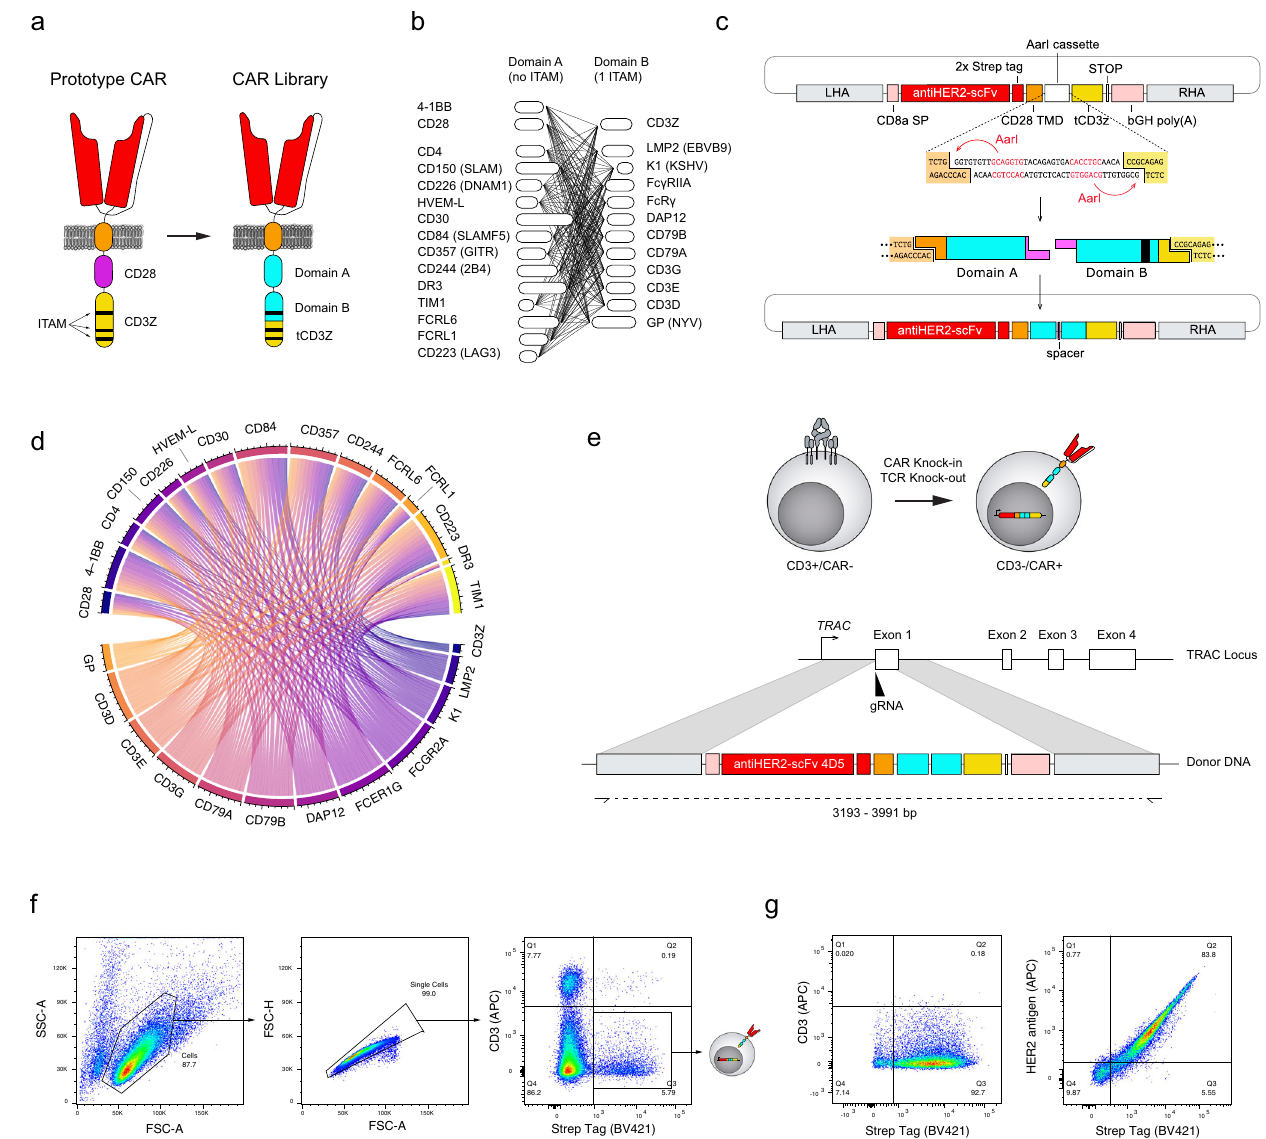
Fig. 1 | Combining modular domain shuf fl ing and genome editing to express a library ofCAR variantsin primary human T cells. a Schematicrepresentation of CAR architecture for the shuf fl ing of signaling domains. The CAR variant library is derived from an initial second-generation CAR featuring the intracellular signaling domains of CD28and CD3 ζ ; the scFv (4D5)is basedonthe variable domains ofthe clinical antibody trastuzumab (speci fi city to the antigen HER2). The entire CD28 signaling domain and a segment of the CD3 ζ domain are exchanged with signaling domains from two pools: Domain A and B, which possess either zero or one ITAM, respectively. A truncated CD3 ζ (tCD3Z) possessing two ITAMs is retained. b Combinatorial shuf fl ing of Domain A and Domain B intracellular sig- naling domains yields a library of 180 possible CAR variants. c Schematic repre- sentation of the cloning strategy for domain shuf fl ing. A backbone vector was designed to encodeaCAR chassiscomposed ofthe following conserved elements: the CD8 ɑ secretion peptide, the scFv 4D5,twoStrep tags separated by G 4 S